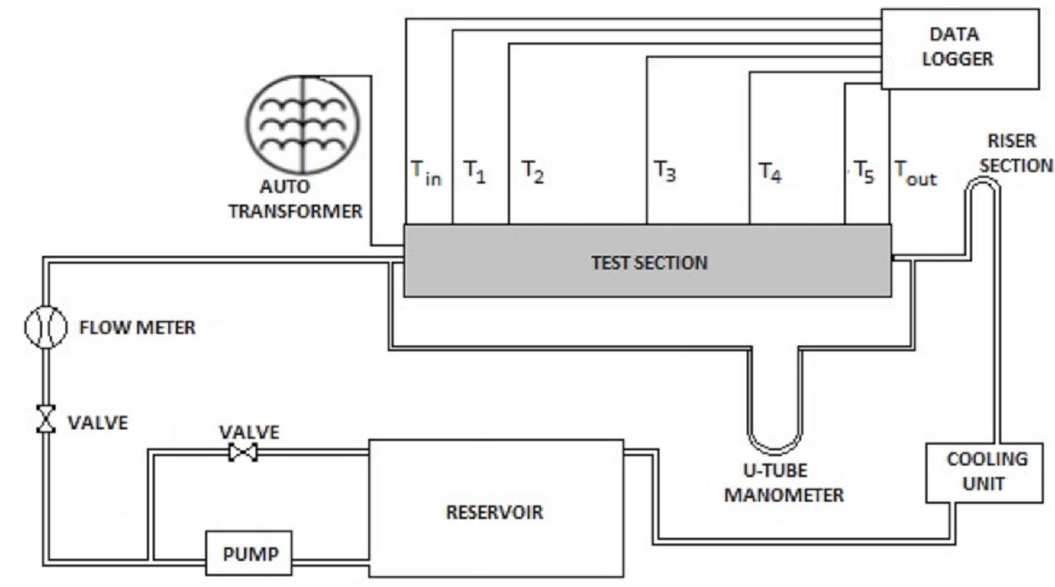
Figure 7. Schematic arrangement of the experimental test facility.